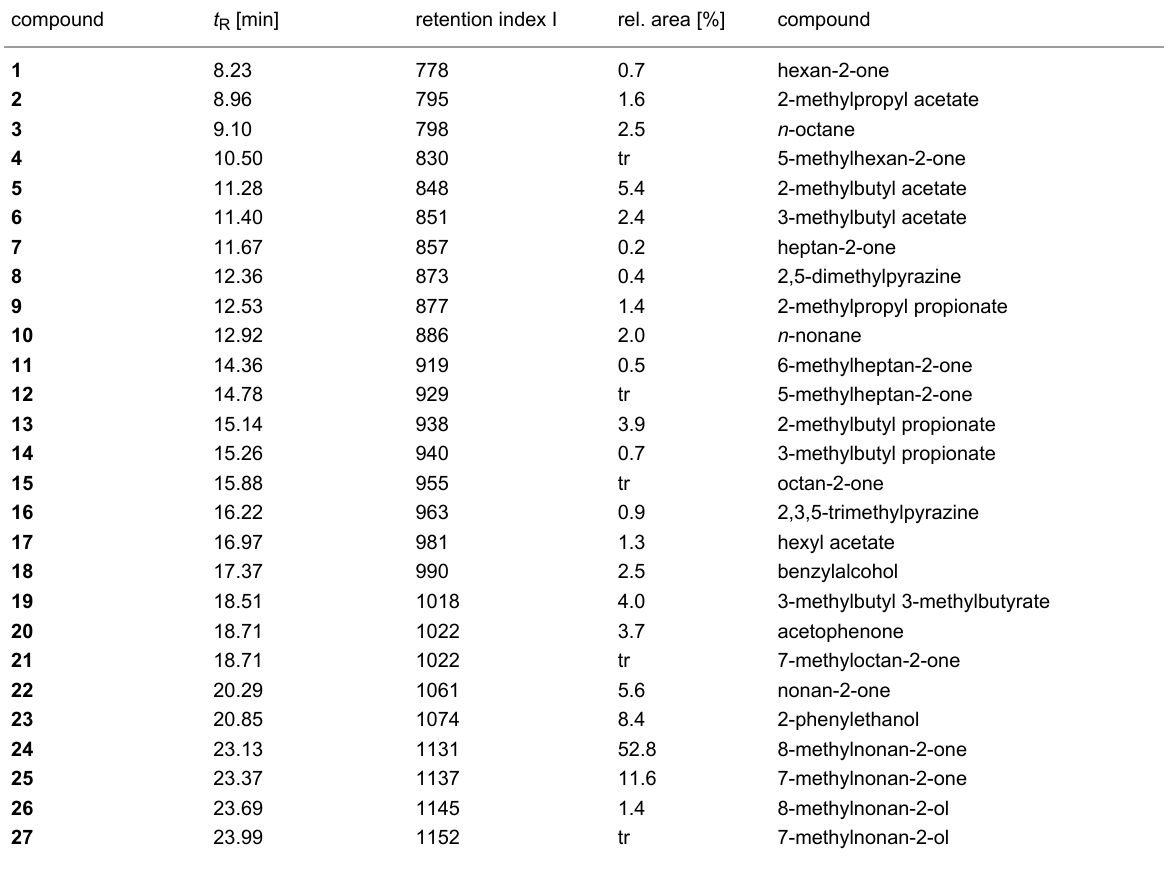
Table 1: GC/MS analysis of Super-Q trapped volatiles emitted by Xanthomonas campestris pv. vesicatoria 85-10 grown in 10 L nutrient broth without glucose. Compound labels are the same throughout this